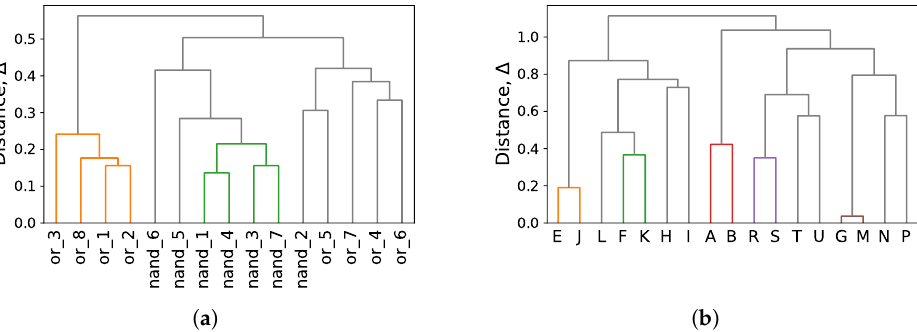
Figure 9. Application of the proposed method to the benchmarks: ( a ) benchmark composed of NAND and OR gates analyzed together; ( b ) benchmark composed of